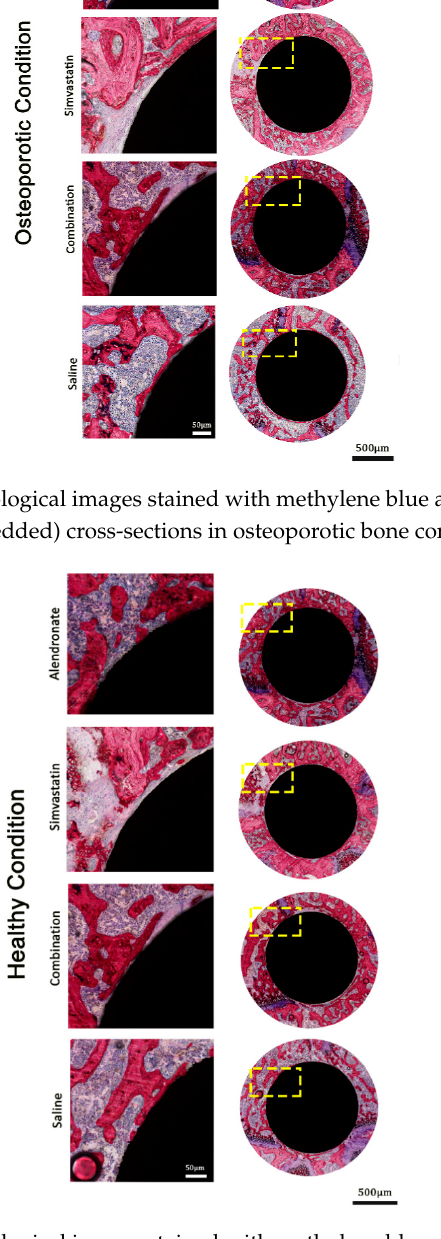
Figure 4. Representative histological images stained with methylene blue and basic fuchsin, showing non-decalcified (pMMA embedded) cross-sections in healthy bone conditions.